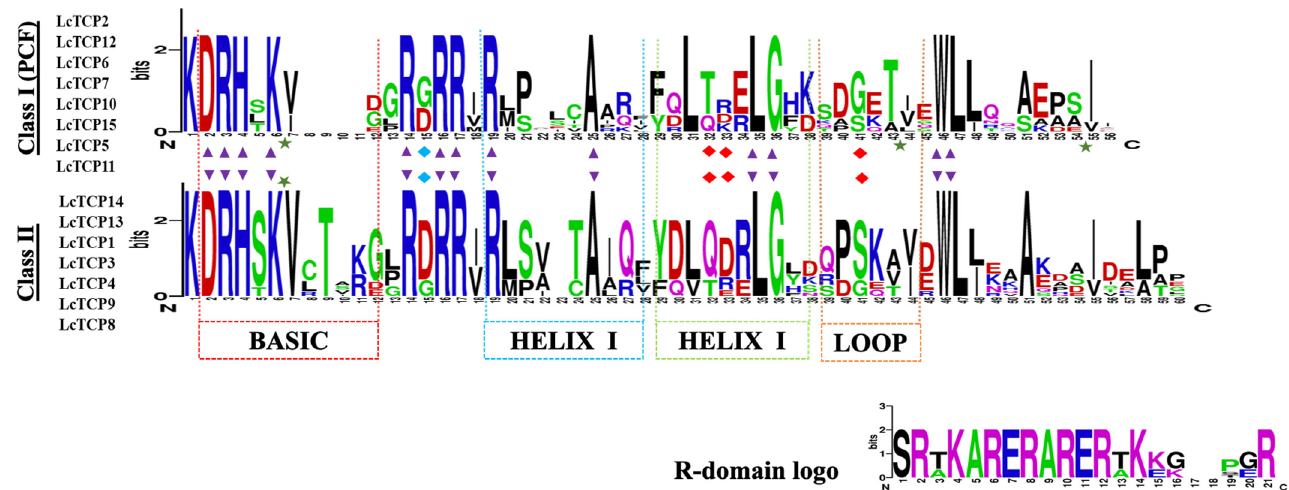
Figure 1. Sequence logos of identified and classified L. chinense TCP protein domains. The sequence logos were generated by WebLogo online tool (http://weblogo.berkeley.edu/), based on the align- ments of the TCP domains. The overall height of each stack letter indicates the sequence conservation at that position (measured in bits). In contrast, the height of the symbols within the stack reflects the relative frequency of the corresponding amino acid at that position. The black arrow depicts 90% conserved loci within the whole family. The red arrow depicts the key DNA binding site for the two subgroups. The top logo shows the PCF domain conserved within the Class I LcTCPs. The mid logo shows the conserved domain in the Class II CIN subclade. The bottom logo shows the R-domain sequence conserved in LcTCP 8/9, classified as the CYC/TB1.